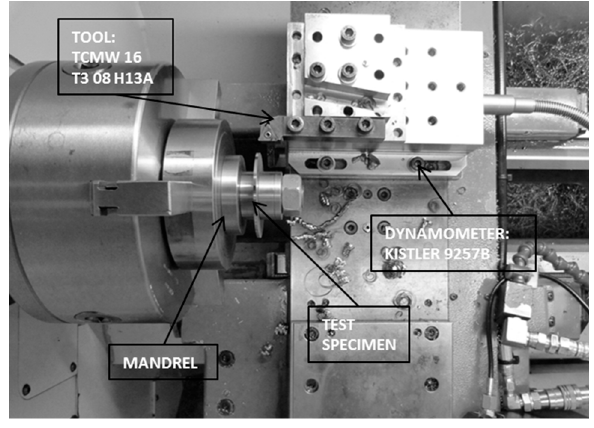
Figure 10. Comparison between the analytical predictions of the constitutive model and experiments at 1900 s − 1 to analyze the influence of ( a ) strain rates and ( b ) temperatures.